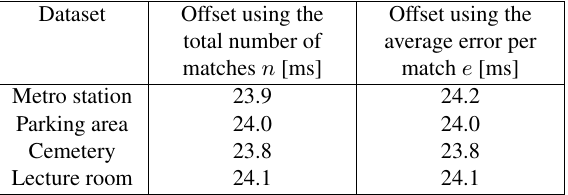
Table 2. Results of the offset computation for all four datasets and for both criteria that were introduced in Subsection